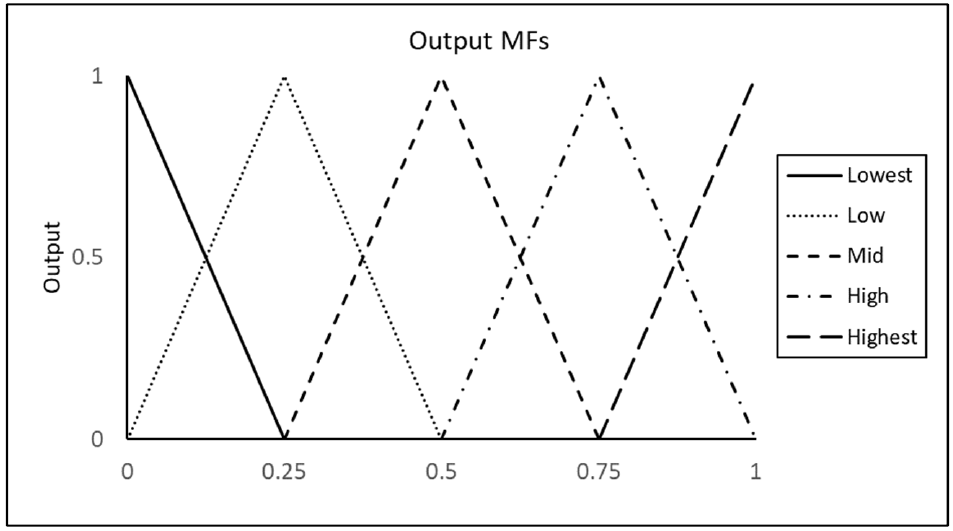
Figure 10. Output MFs.